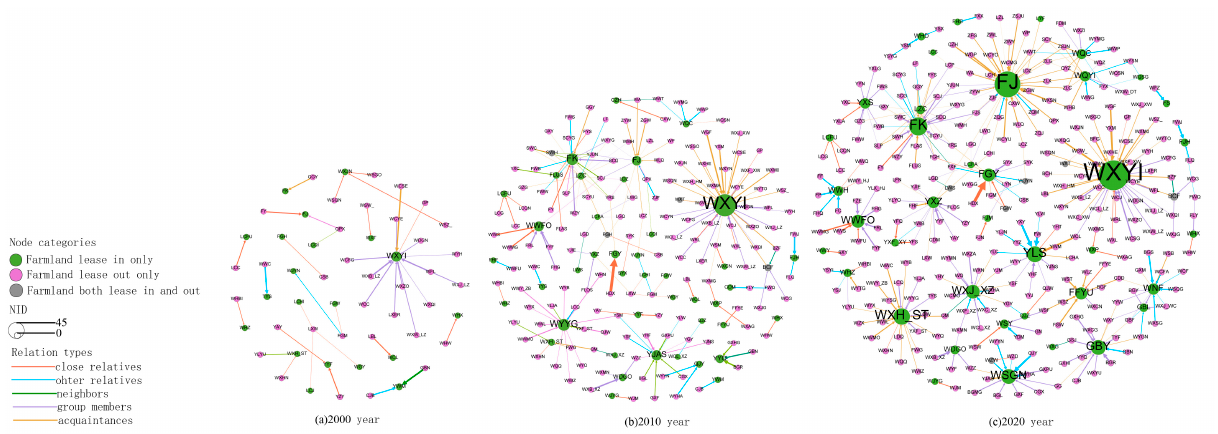
Figure 5. Digraphs of farmland leasing network in the first wave (2000), second wave (2010), and third wave (2020).